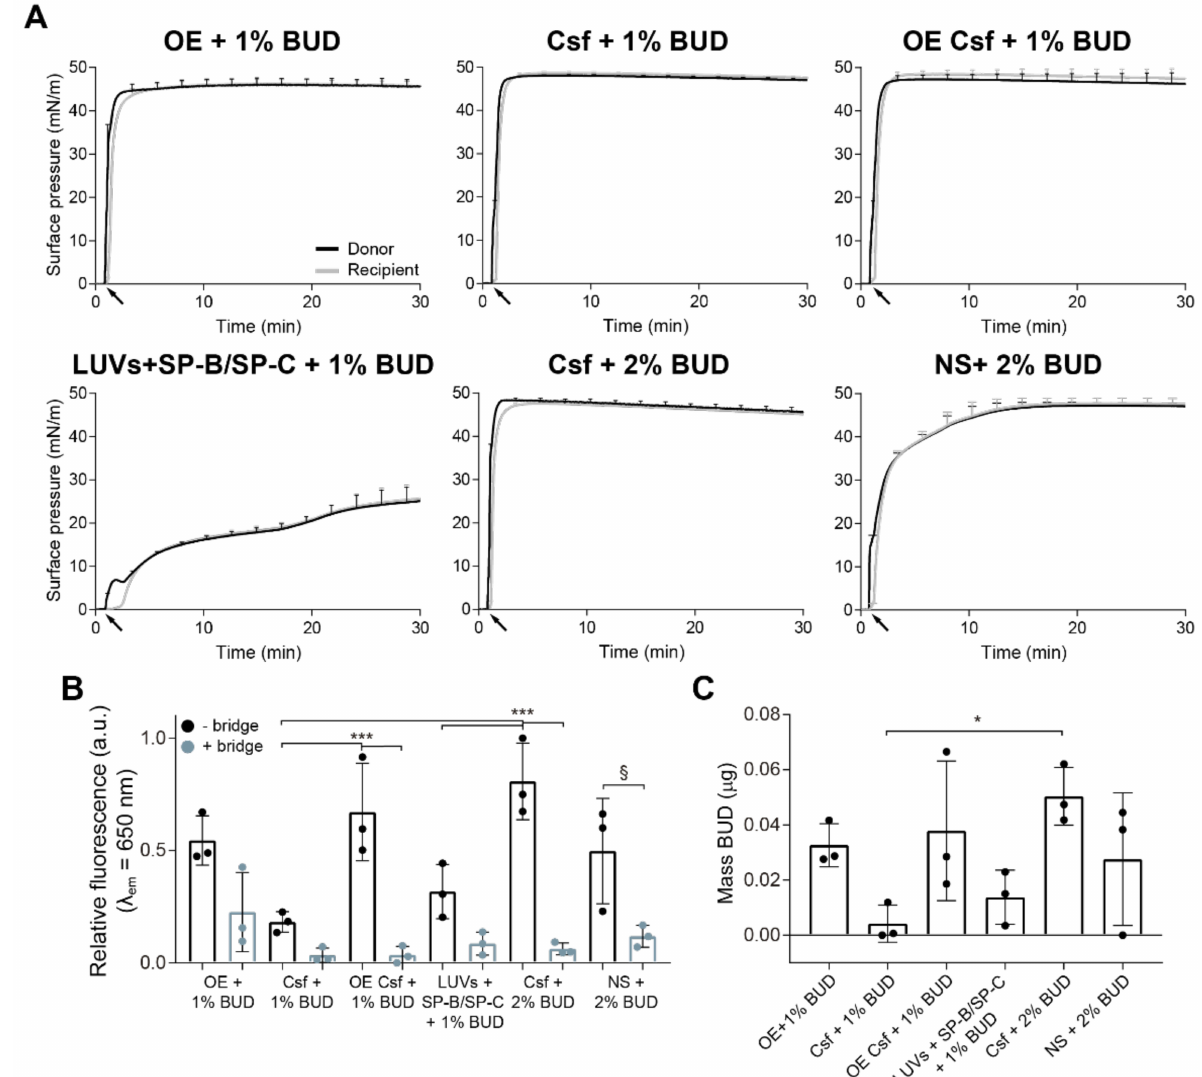
Figure 5. Interfacial vehiculization of budesonide (BUD) through pulmonary surfactant preparations. ( A ) Adsorption/spreading isotherms of aqueous suspensions of OE (top left), Csf (top middle), aqueous suspension of an OE of Csf (top right) and proteo-lipid LUVs (bottom left) combined with 1% ( w / w with respect to total mass of phospholipids) BUD, and Csf (bottom middle), and NS (bottom right) in combination with 2% ( w / w ) BUD. Fifteen µ L of each material at 20 mg/mL were deposited dropwise onto the donor interface (black arrows) and the changes in surface pressure were monitored during 30 min in both compartments. ( B ) Relative fluorescence emission of F-BUD (BUD) at λ em = 650 nm at the recipient interfacial film collected by aspiration at the end of each experiment. Comparison of the fluorescence obtained for the different materials in experiments without (black bars) and with (blue bars) the bridge. ( C ) Comparison of the amount in µ g of BUD transported by different materials to the recipient interface in experiments performed without the paper bridge. Data represents mean and standard deviation from at least three replicas. One-way ANOVA followed by Tukey’s post-hoc test: ( B ) p < 0.001; ( C ) p = 0.043. (§) p = 0.05, (*) p < 0.05 and > 0.01 and (***) p ≤